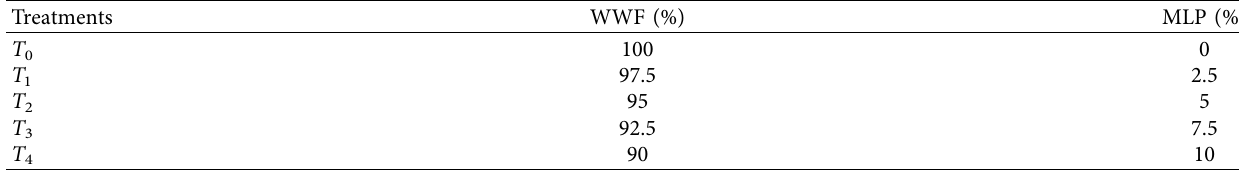
Table 1: Treatment plan for moringa leaf powder (MLP)-supplemented whole wheat four (WWF) leavened bread development. Treatments